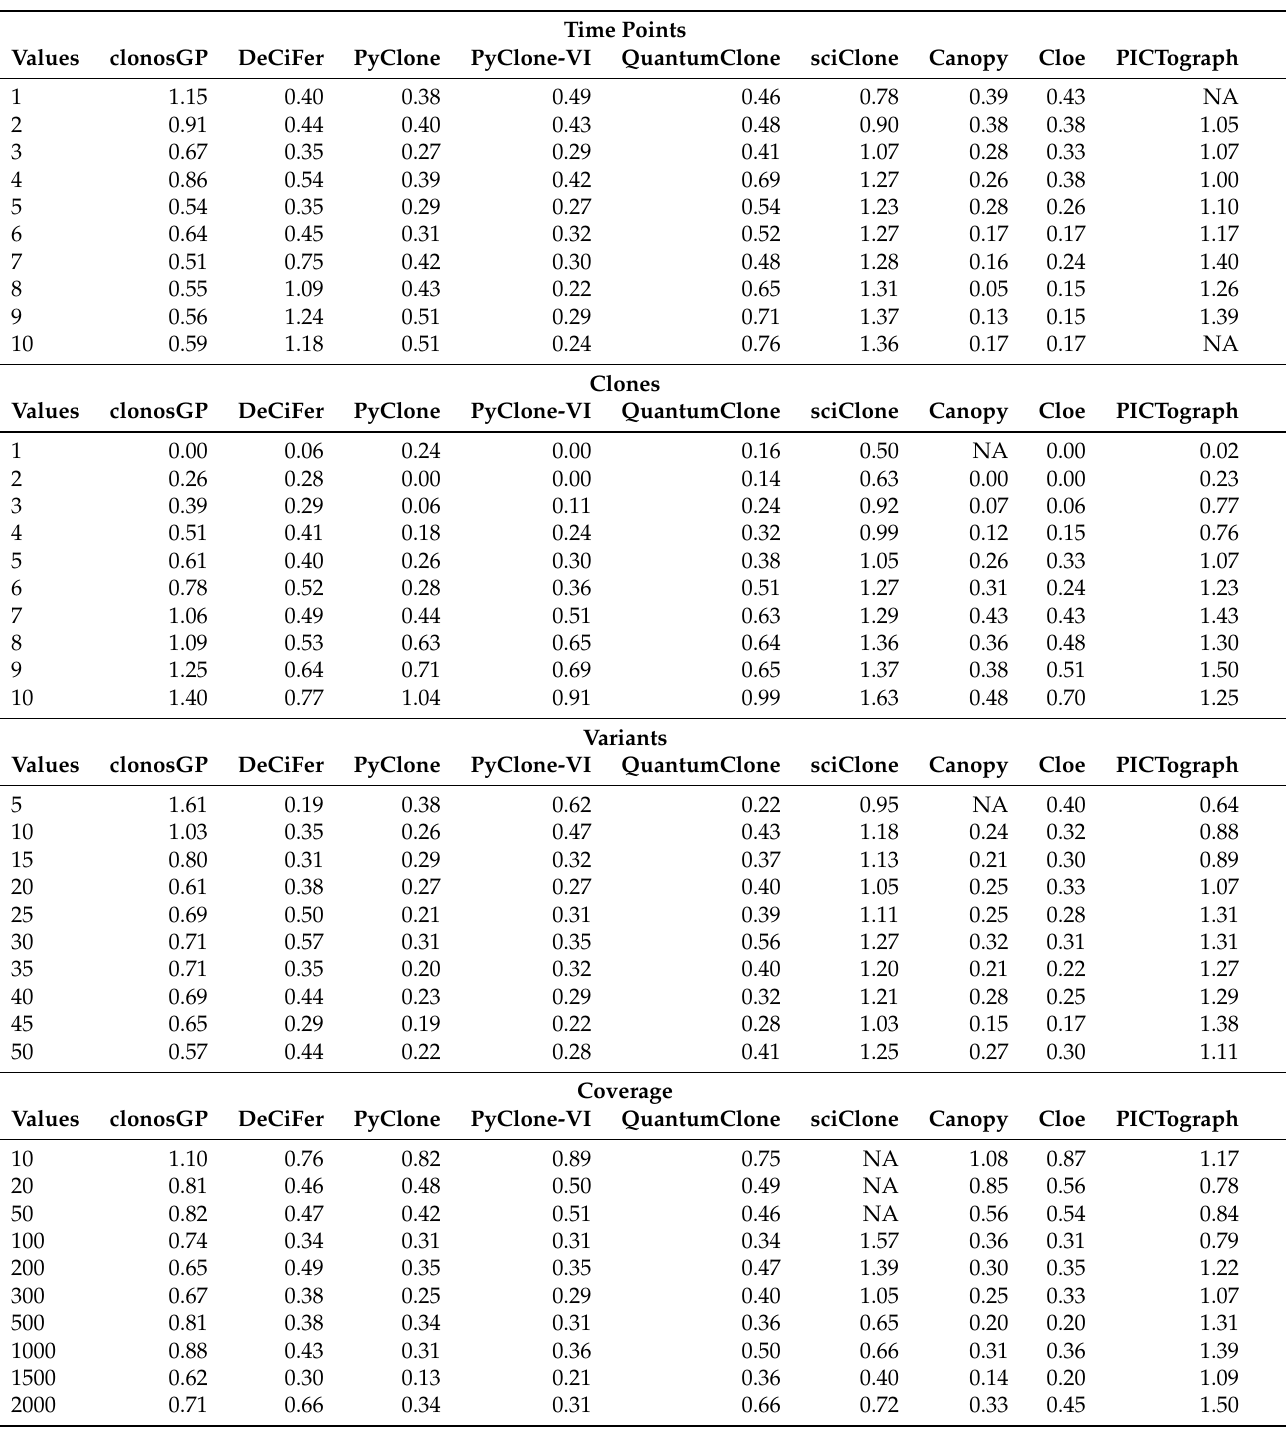
Table A2. Variation of information comparing variant clustering performed using clonosGP, De- CiFer, PyClone, PyClone-VI, QuantumClone, sciClone, Canopy, Cloe, and PICTograph in the ab- sence of CNVs to simulate truth. Different numbers of time points, clones, variants, and coverage were